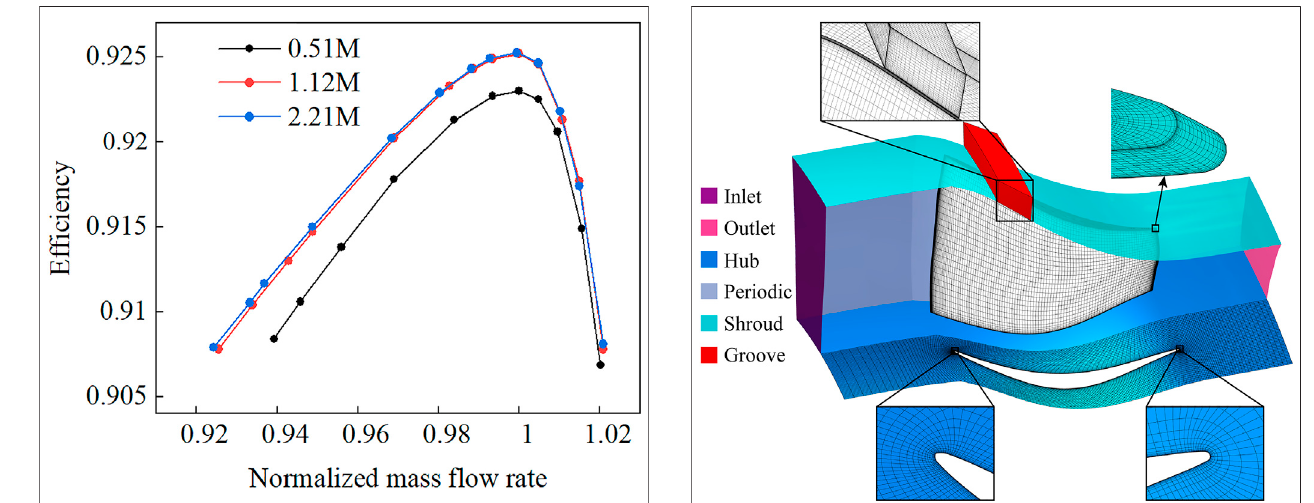
FIGURE 3 | Schematic diagram of the total computational